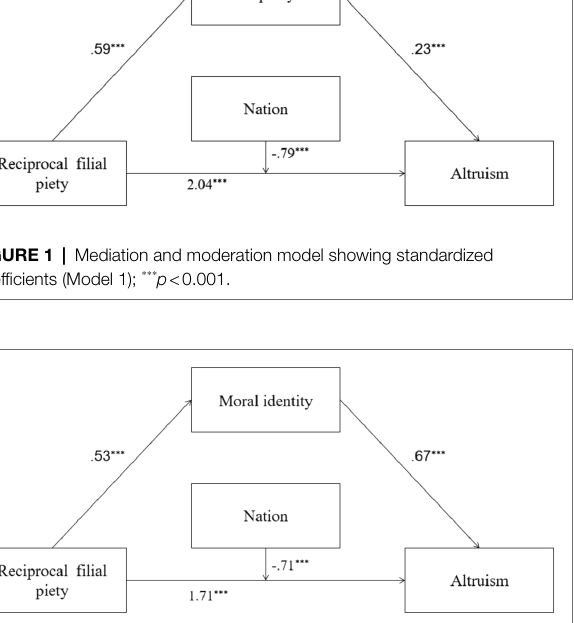
FIGURE 4 | Mediation and moderation model showing standardized coefficients (Model 4); * p < 0.05; *** p <